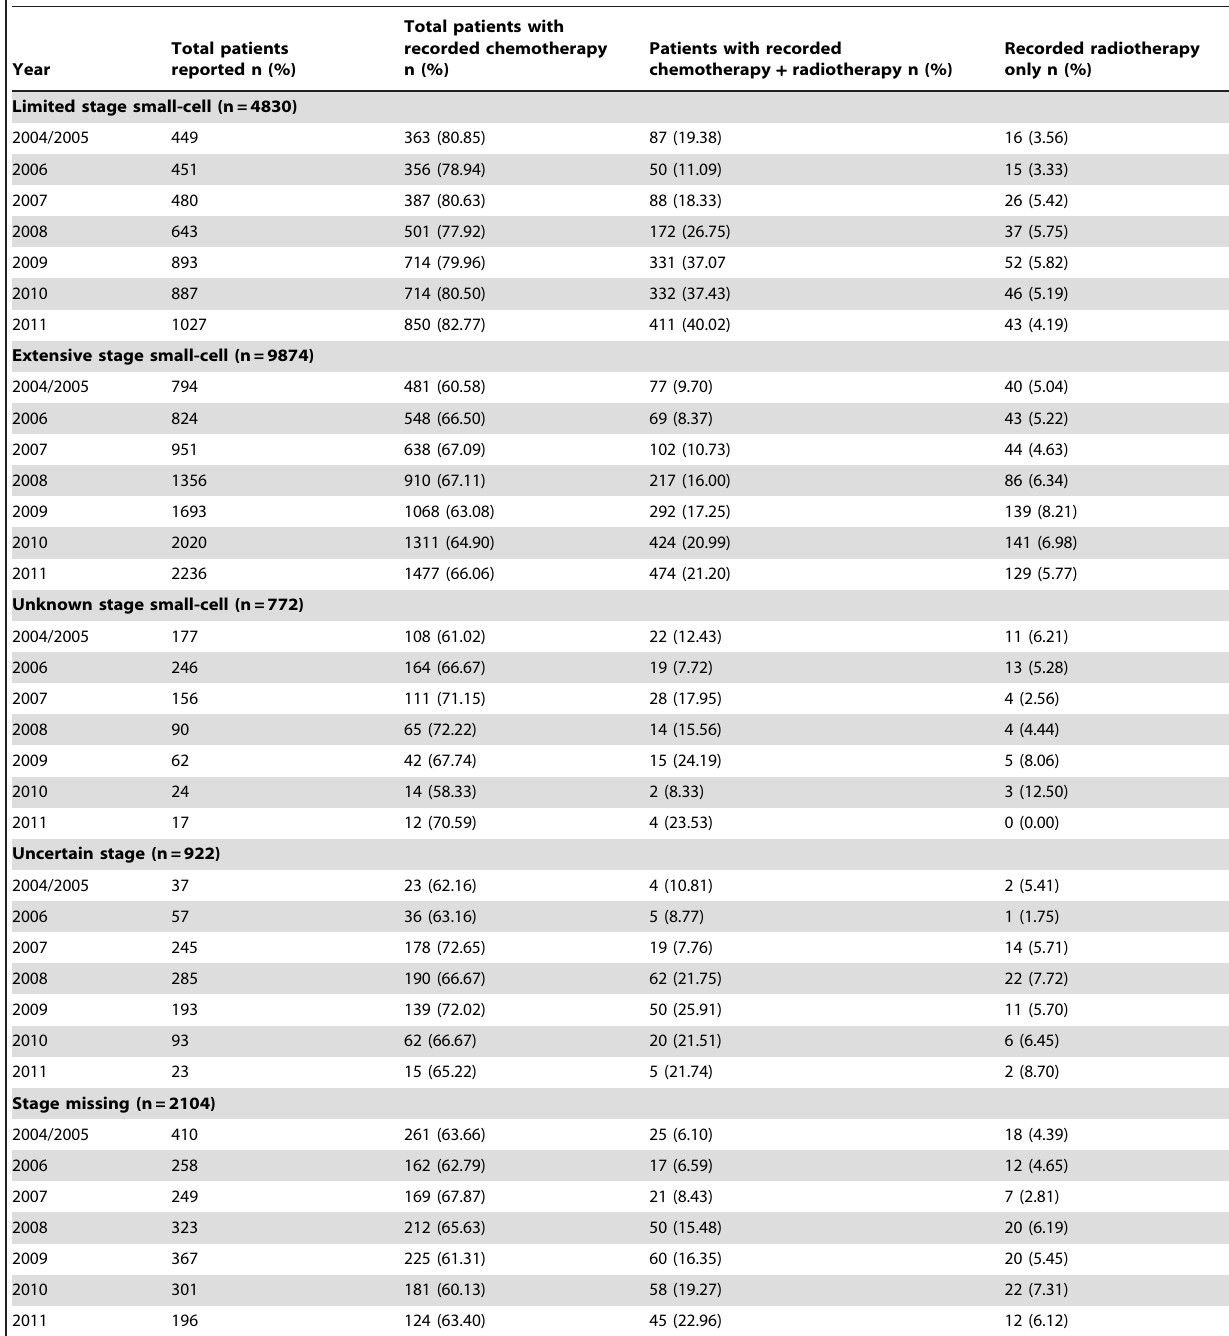
Table 3. Proportion of people receiving chemotherapy and radiotherapy by stage (n= 18513).